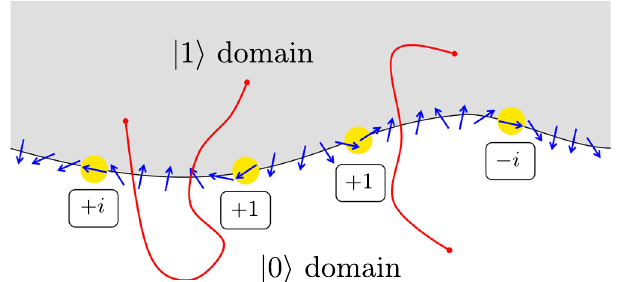
FIG. 14. Here, as we move left to right along the domain wall, the interpolating vector field (blue arrows) rotates. When it rotates clockwise from pointing towards the j 0 i domain (white) to pointing towards the j 1 i domain (gray), we get a phase of þ i . When it rotates clockwise from pointing towards the j 1 i domain to pointing towards the j 0 i domain, we obtain a phase of − i . Counterclockwise rotations of the vector field along the domain wall give a trivial phase. The twist of the vector field near an edge in E (red edges), as displayed in Fig. 10, does not affect the calculation of this (cid:2) i as determined by the rotation of the vector field at the points of tangency, as detailed above.